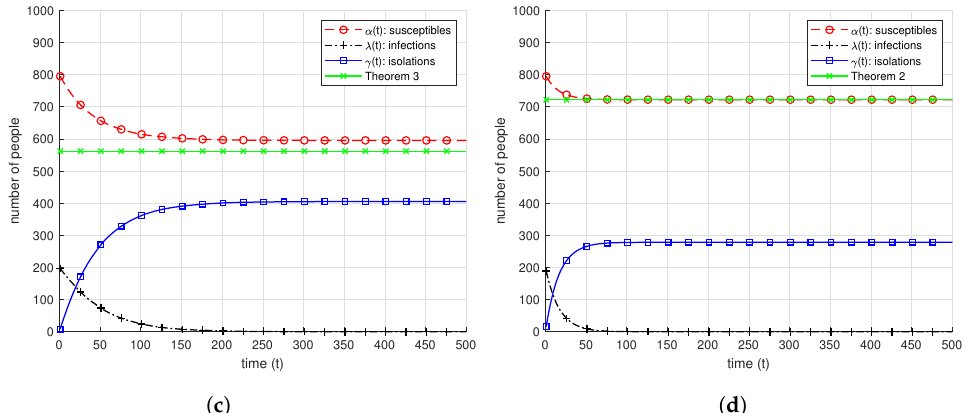
Figure 1. Average values of the random processes α ( t ) , λ ( t ) and γ ( t ) , with obtained theoretical approximations given in Theorems 1–3 when n = 1000, T = 80, q = 0.00003, p = 0.2, for ( a ) dynamic Dorfman type group testing algorithm, ( b ) dynamic individual testing algorithm, ( c ) weak dynamic Dorfman type group testing algorithm, ( d ) weak dynamic individual testing algorithm.